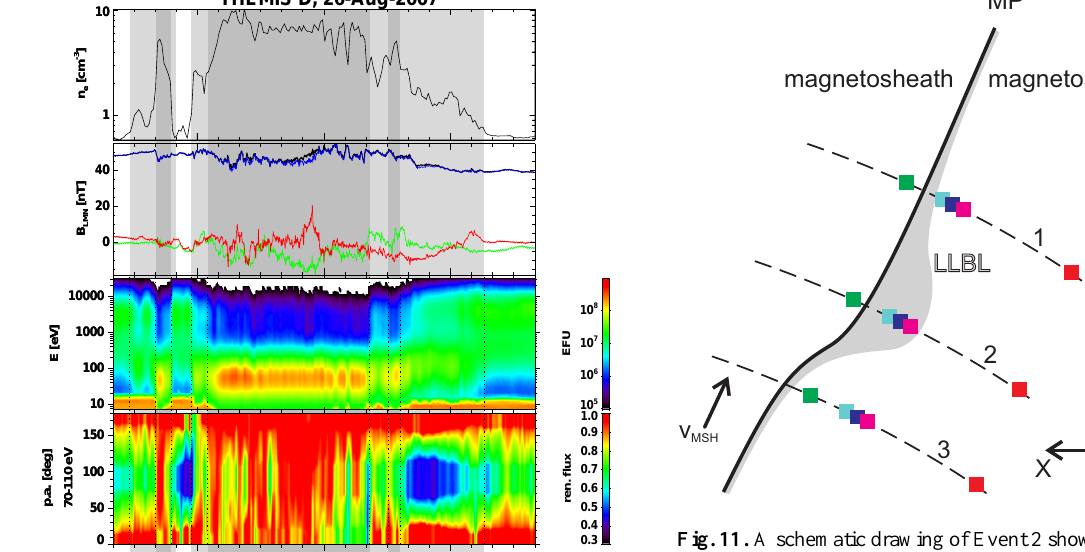
Fig. 11. A schematic drawing of Event 2 showing the thickening of the LLBL due to a change of the B Z component. The magnetopause motion in time is represented by different THEMIS locations. A shadowed area indicates changing thickness of the outer